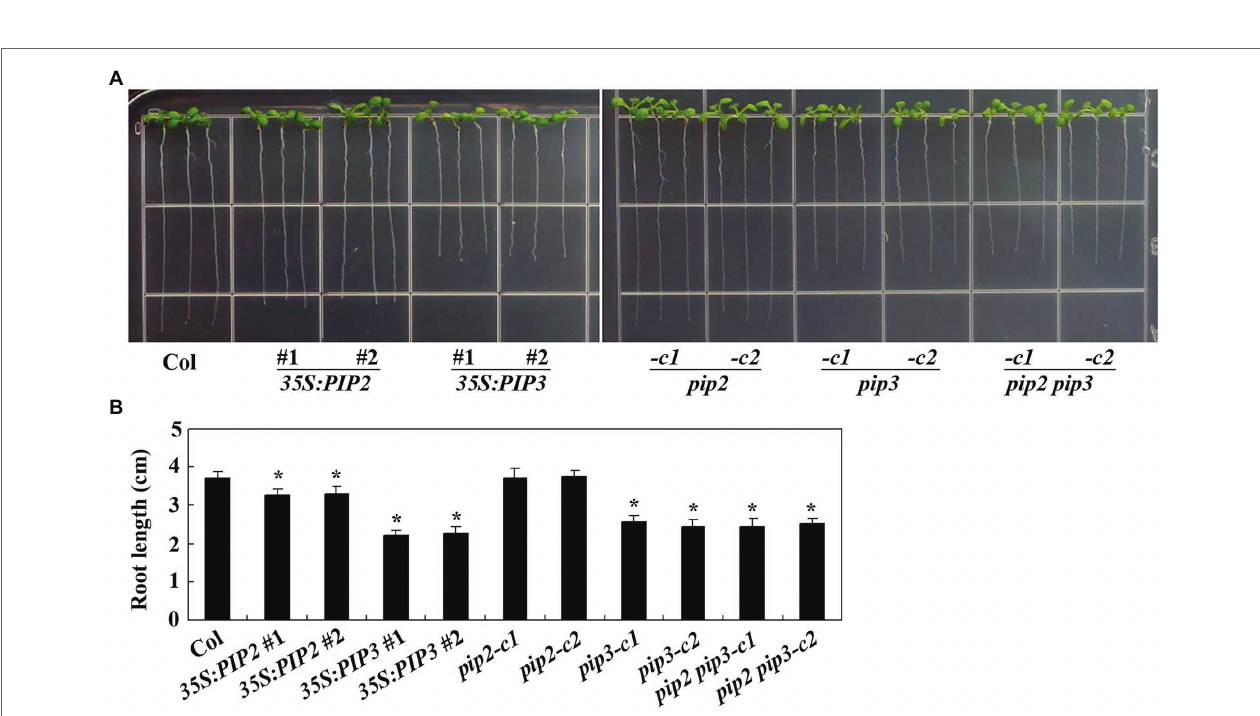
FIGURE 5 | PIP2 and PIP3 affect root elongation. (A) Root elongation in seedlings of the Col wild type, the 35S:PIP2 and 35S:PIP3 transgenic plants, and the pip2 , pip3 and pip2 pip3 mutants. Seeds were sterilized and plated on 1/2 Murashige and Skoog (MS) plates, kept at 4 ° C and in darkness for 2 days before transferred to a growth room and grown vertically for 8 days. Pictures were taken by using a digital camera. (B) Root length in seedlings of the Col wild type, the 35S:PIP2 and 35S:PIP3 transgenic plants, and the pip2 , pip3 , and pip2 pip3 mutants. Root length of 8-day-old seedlings was measured. Data represent the mean ± SD of 21–25 seedlings. *significantly different from that of the Col wild type seedlings (student’s t -test, p < 0.001). The experiments were repeated three times with similar